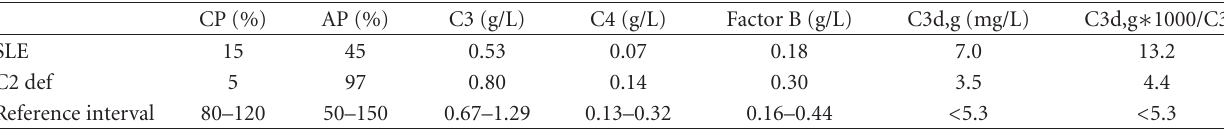
Table 1: Complement function of the CP and AP, plasma concentrations of C3, C4, factor B, and C3d,g, and the C3d,g ∗ 1000/C3 ratio in one patient with SLE and one patient with a C2 deficiency.